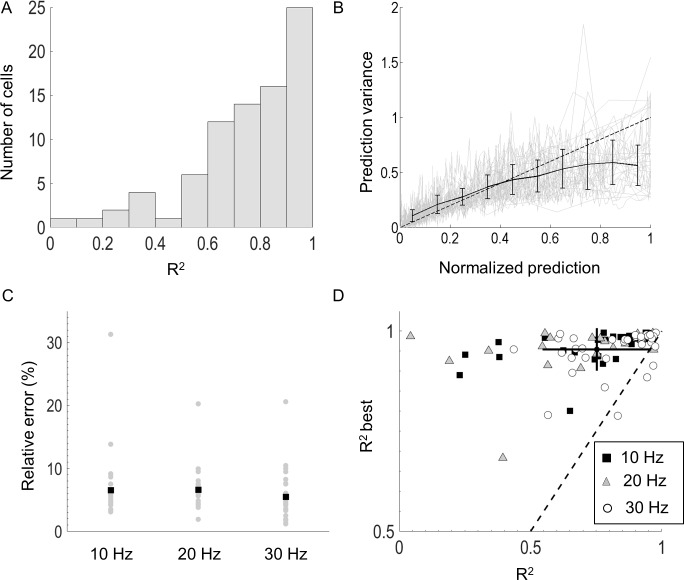
Model validation.A) The predicted response was compared to the observed responses from which a coefficient of determination was computed. Most cells achieved a high R2 value. B) The normalized prediction was compared to the normalized prediction variance (grey lines). A trend of lower prediction variance was observed for higher amplitudes of the generator function (black line). C) The perentage error relative to the maximal response for all cells (grey) at the three stimulation frequencies. Black squares denote the means. D) The measured R2 value was compared to the best case value computed by simulating a Poisson process with the estimated mean. The cross-hair denotes the average R2 for all cells (0.75) and the best case value assuming a Poisson process (0.94). The lengths of the lines denote ±1 standard deviation for each axis.